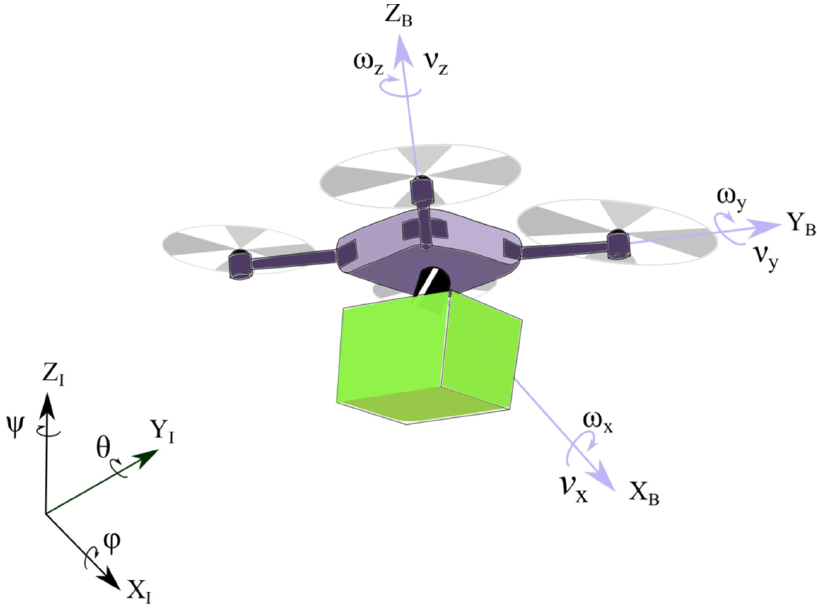
Figure 1. Schematic illustration of a quadrotor carrying a payload.